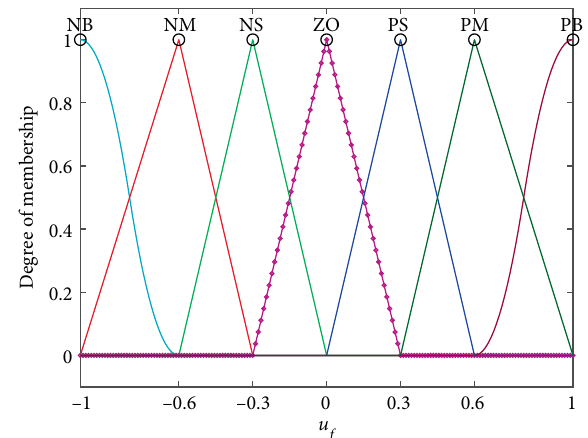
Figure 5: The output membership function of